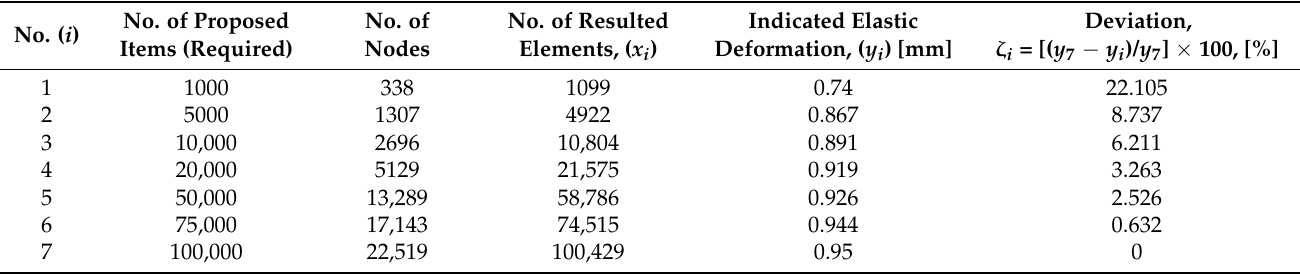
Table 6. Deformation values obtained at compression and bending study of a pole with arm in the console by using finite element analysis.